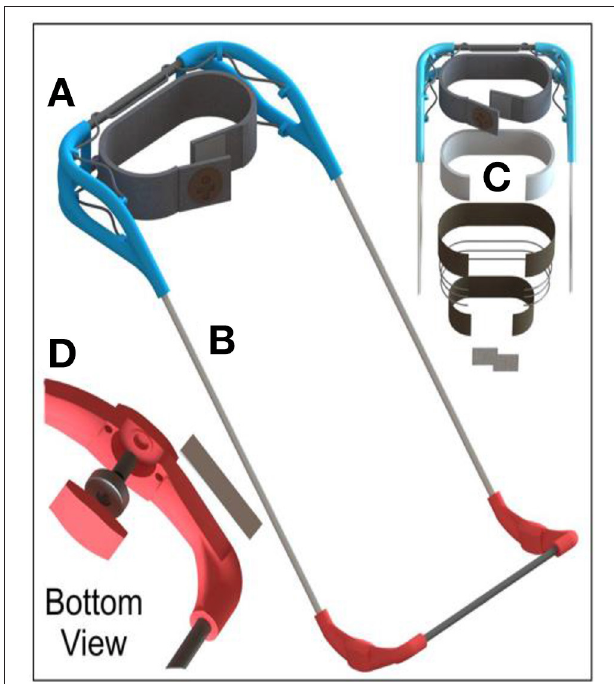
FIGURE 2 | Rendering of the P20 prototype wearable cane. (A) Plastic handles. (B) Carbon fiber tubes. (C) Layers of the belt. (D) Ball bearing, Shaft, steel plate & plastic